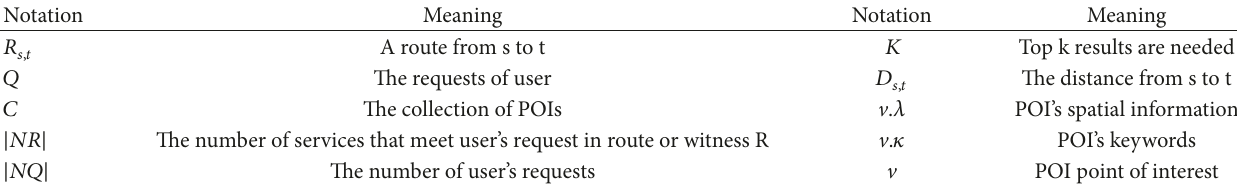
Table 2: Meaning of notations.